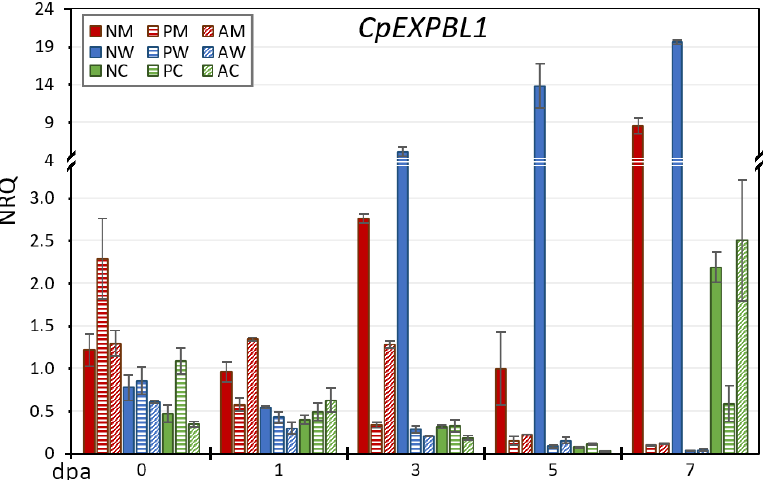
Figure A2. CpEXPBL1 normalized relative quantities for all treatments and genotypes. Auxin- treated (A), Pollinated (P), Non-treated (N); Genotype MUCU-16 (M), Whitaker (W) and Cavili (C). CpEXPBL1 ( expansin-like B1). Error bars are standard error (n = 3).